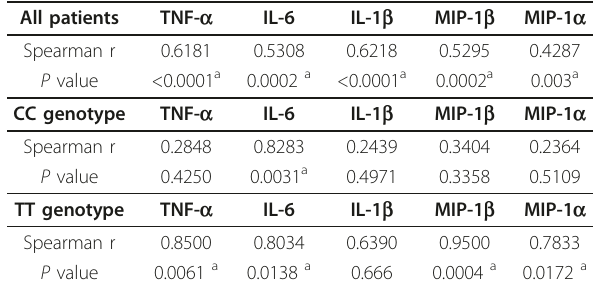
Table 3 Correlation between cell count and cytokines and chemokines level in BM patients All